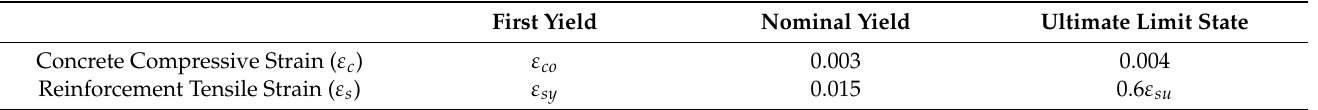
Figure 10. A typical moment–curvature curve and bi-linear approximation. Table 3. Material strain limits for moment–curvature analyses of lightly reinforced load-bearing precast